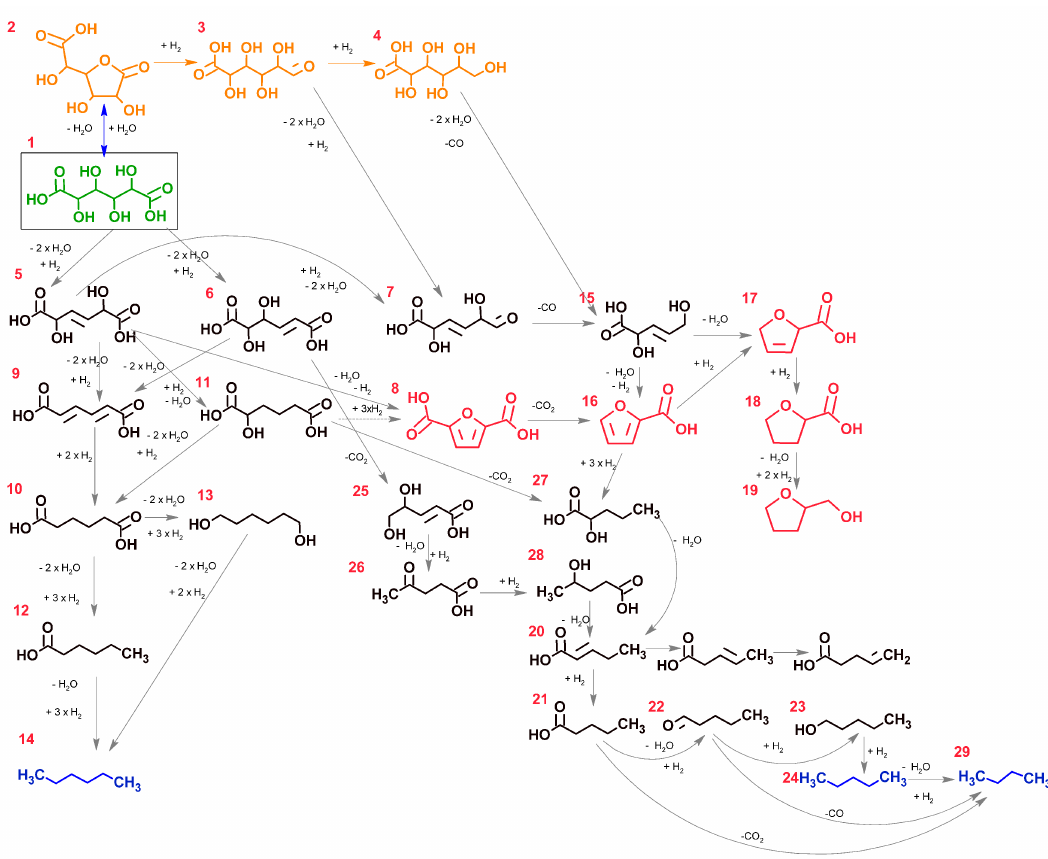
Figure 2. Proposed reaction pathway development based on HPLC, LC–MS, and GC-MS